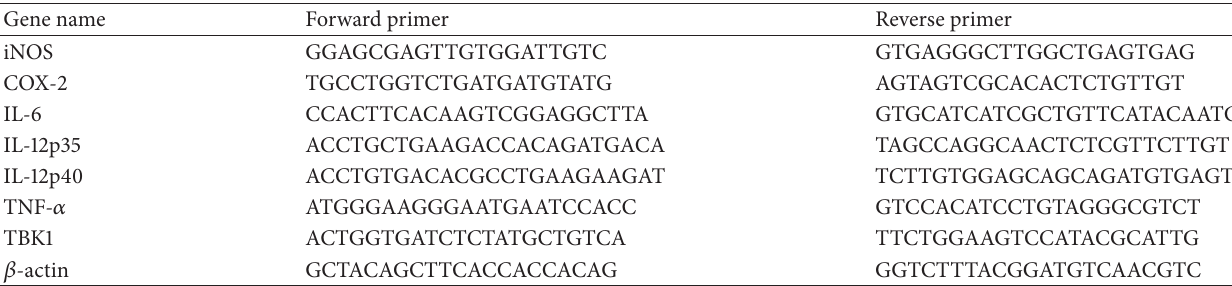
Table 1: Primer sets for